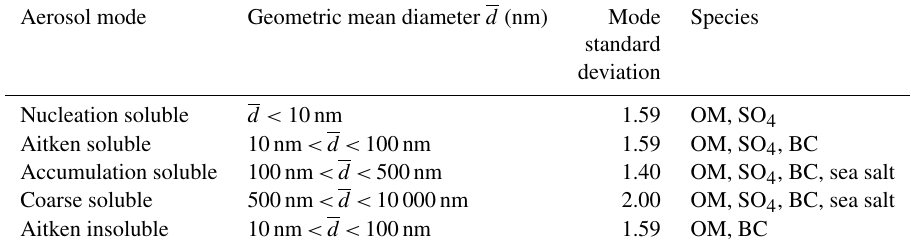
Table A1. The different aerosol size modes in UKESM along with their size ranges, mode standard deviation and aerosol species in each mode. The species are organic matter (OM), sulfate (SO 4 ), BC (black carbon) and sea salt. Dust is treated separately as described in the text.